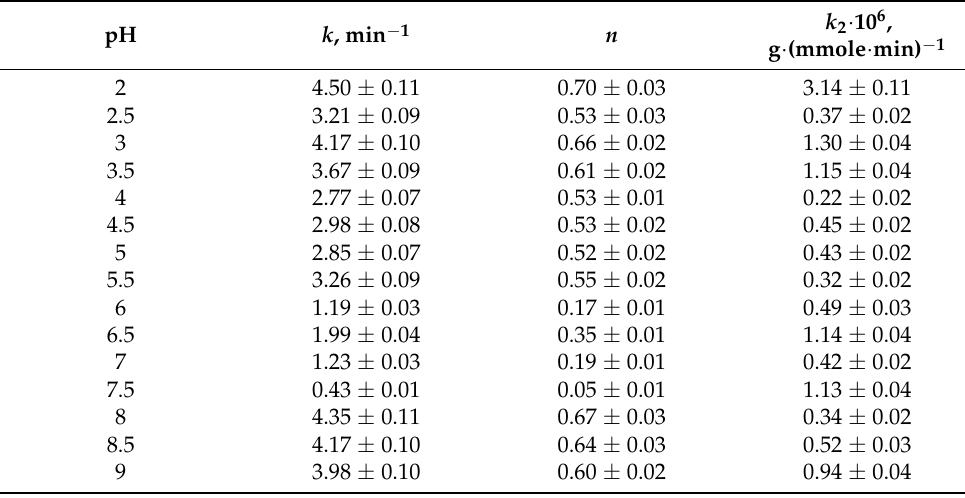
Table 1. Sorption parameters of HP ‐ Fe .